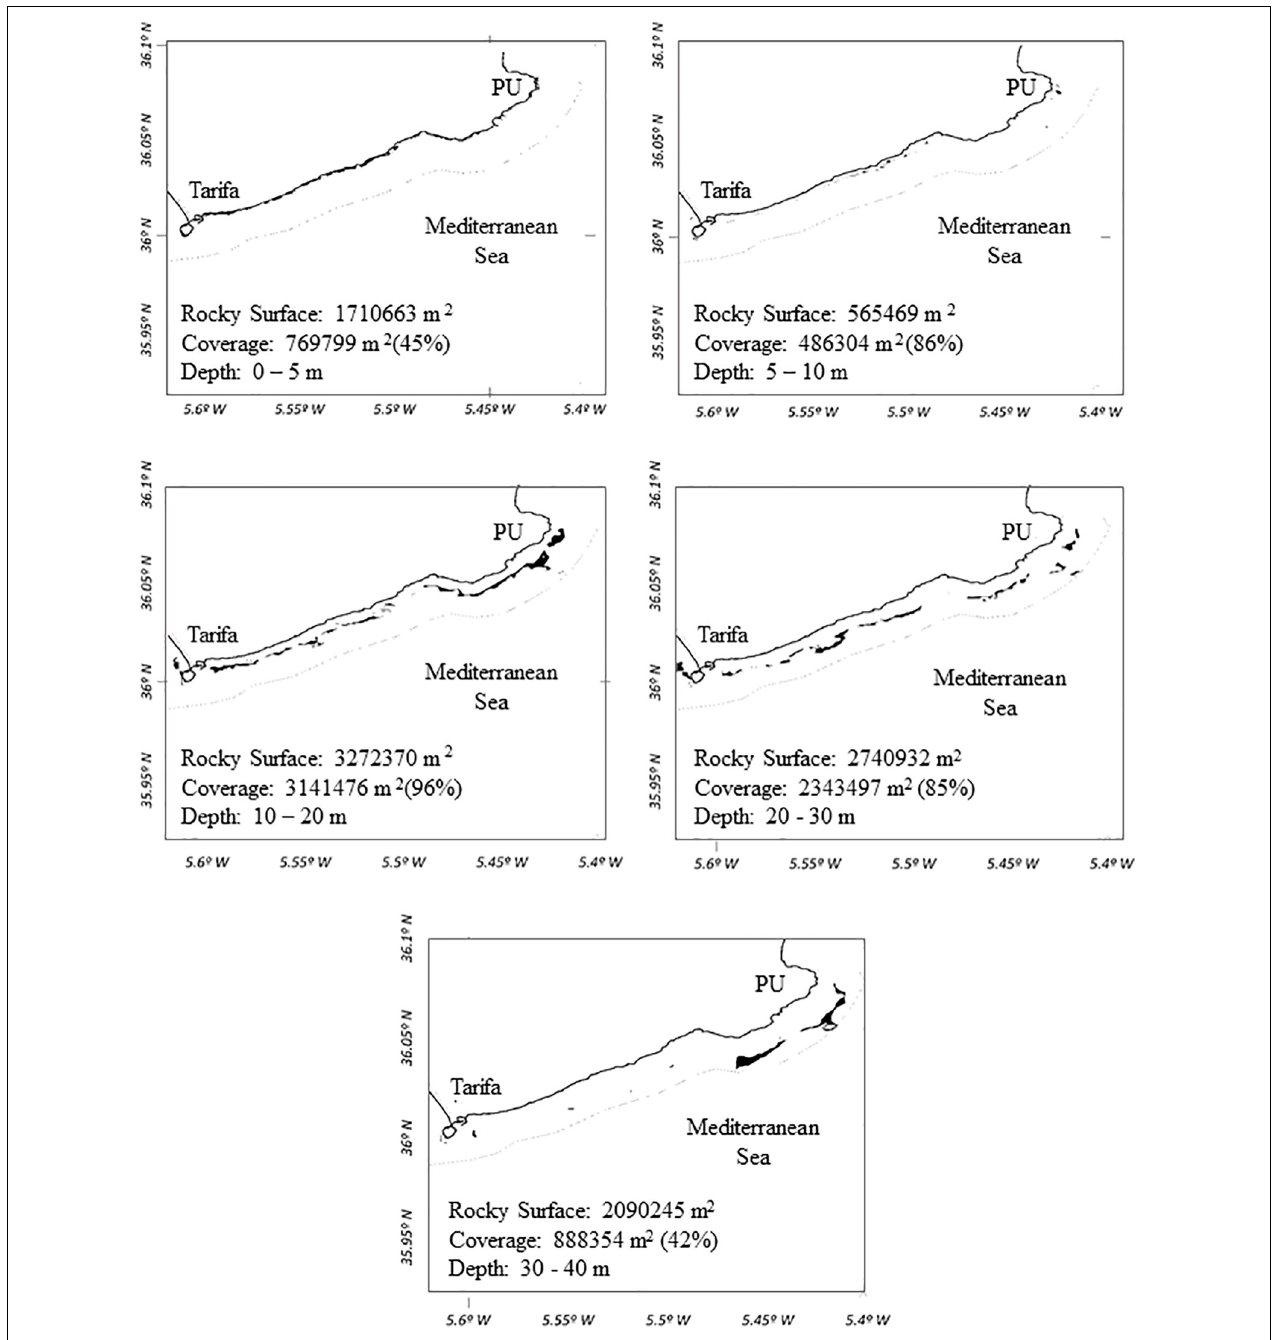
FIGURE 6 | Rocky surface areas (m 2 ) (black patches) mapped for the eastern sublittoral of the PNE (1 mile from the coast). Percentage coverages of R. okamurae at the different bathymetric intervals are represented (0–5, 5–10, 10–20, 20–30, and 30–40 m). PU = Punta